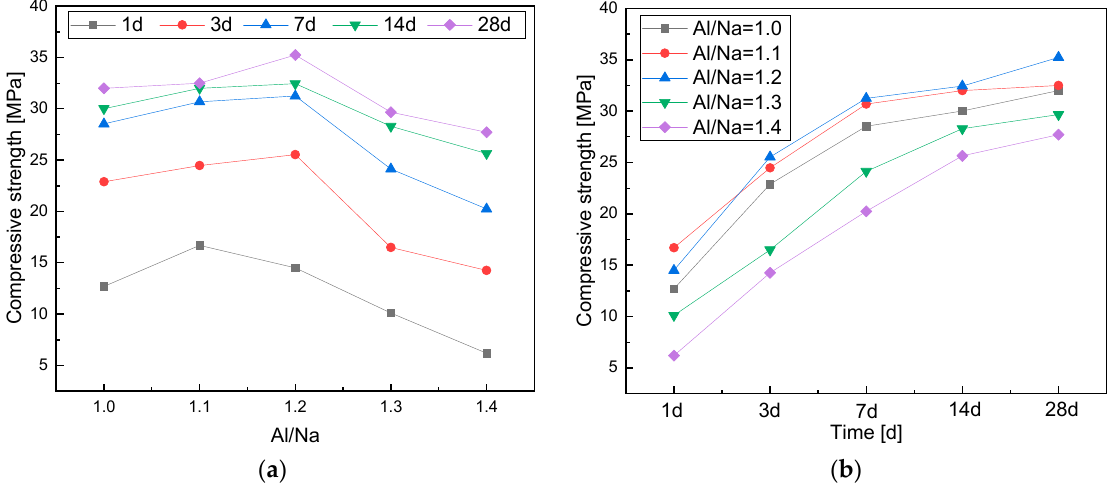
Figure 4. ( a ) A chart of the changes in compressive strength with Al/Na ratio; ( b ) a chart of the changes in compressive strength with age.